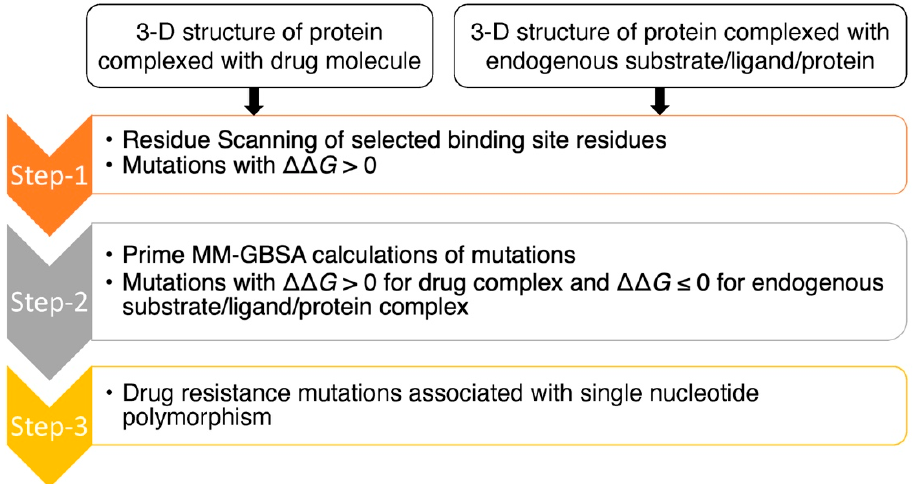
Figure 1. Flow chart of computational approach for the prediction of drug resistance mutations.